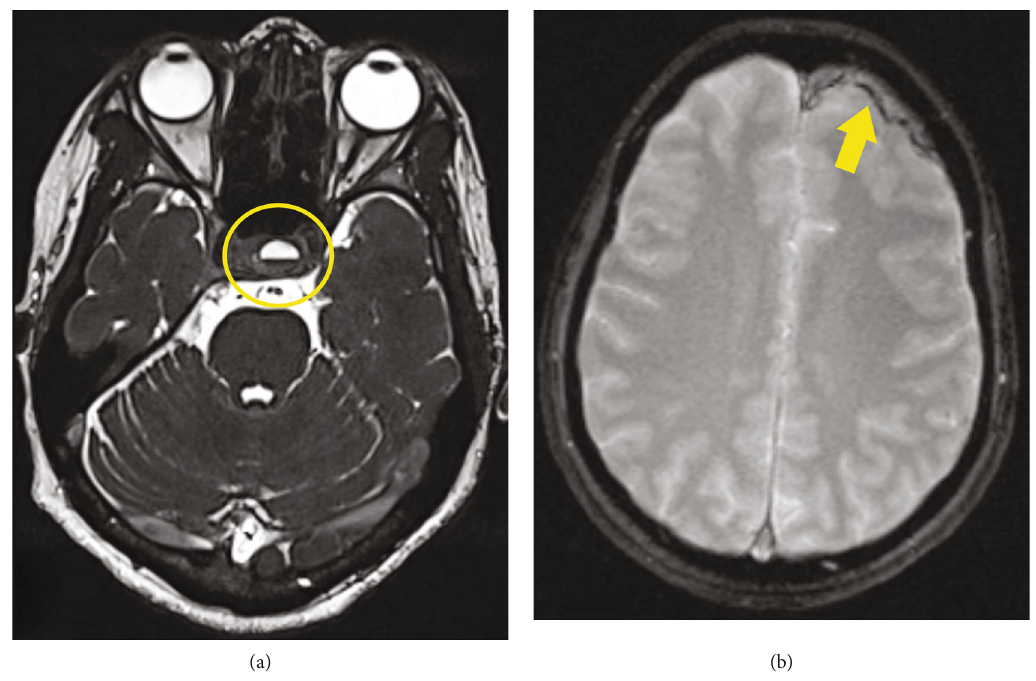
Figure 2: (a) CISS 3D MRI image shows the level of fl uid debris in the pituitary fossa (circle). (b) T2 ∗ -weighted gradient-echo MRI image shows the signal intensity of a subdural hematoma